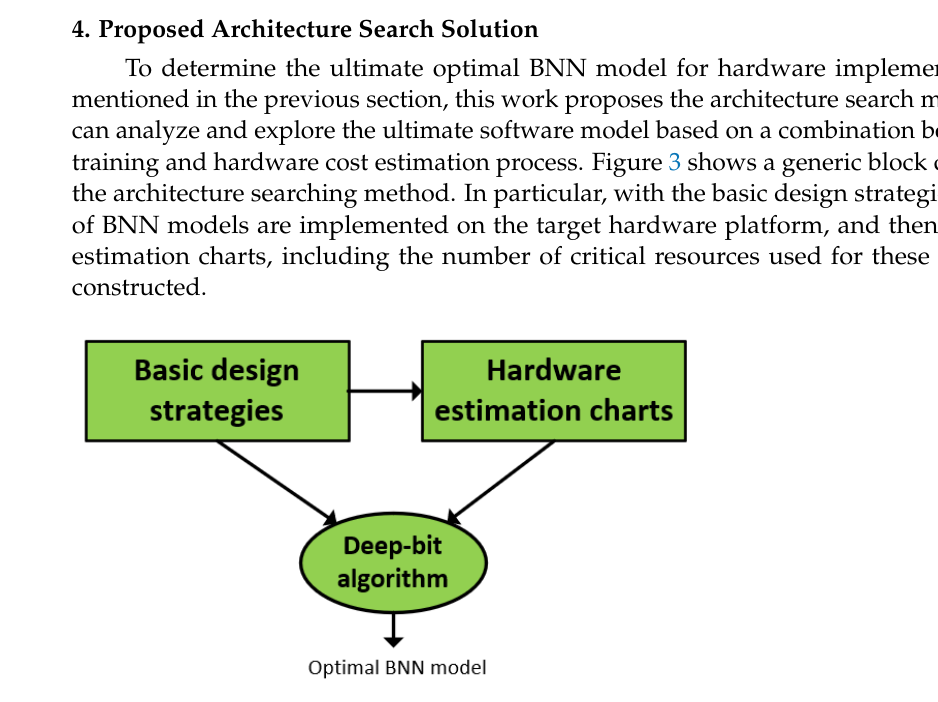
Figure 2. The building module for a network architecture: ( a ) layer module for our network architec- ture; ( b ) layer module for our network architecture with Max pooling.